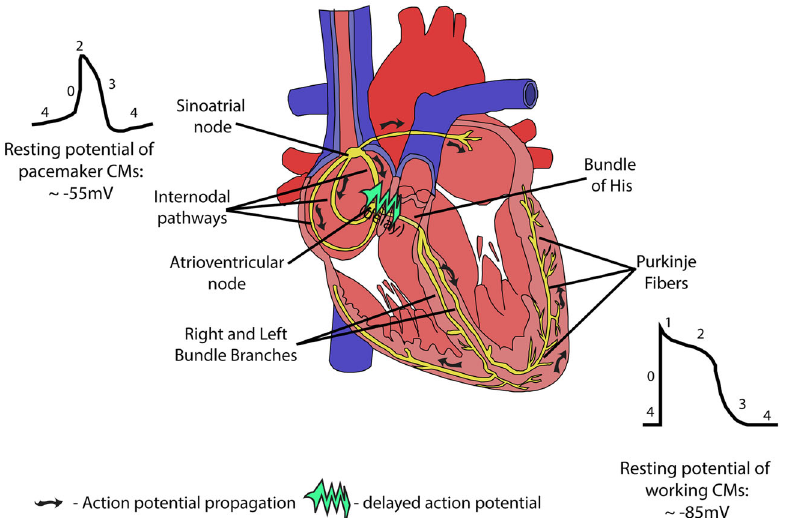
Fig. 1 Representation of the anatomy of the cardiac conduction system and the path of the action potential propagation ( arrows ) including the time delay observed at the AV junction ( green arrow ). The shape of the AP on SAN ( upper left ) and working myocytes ( lower right ) are represented along with the respective resting potentials and the different phases of the signal